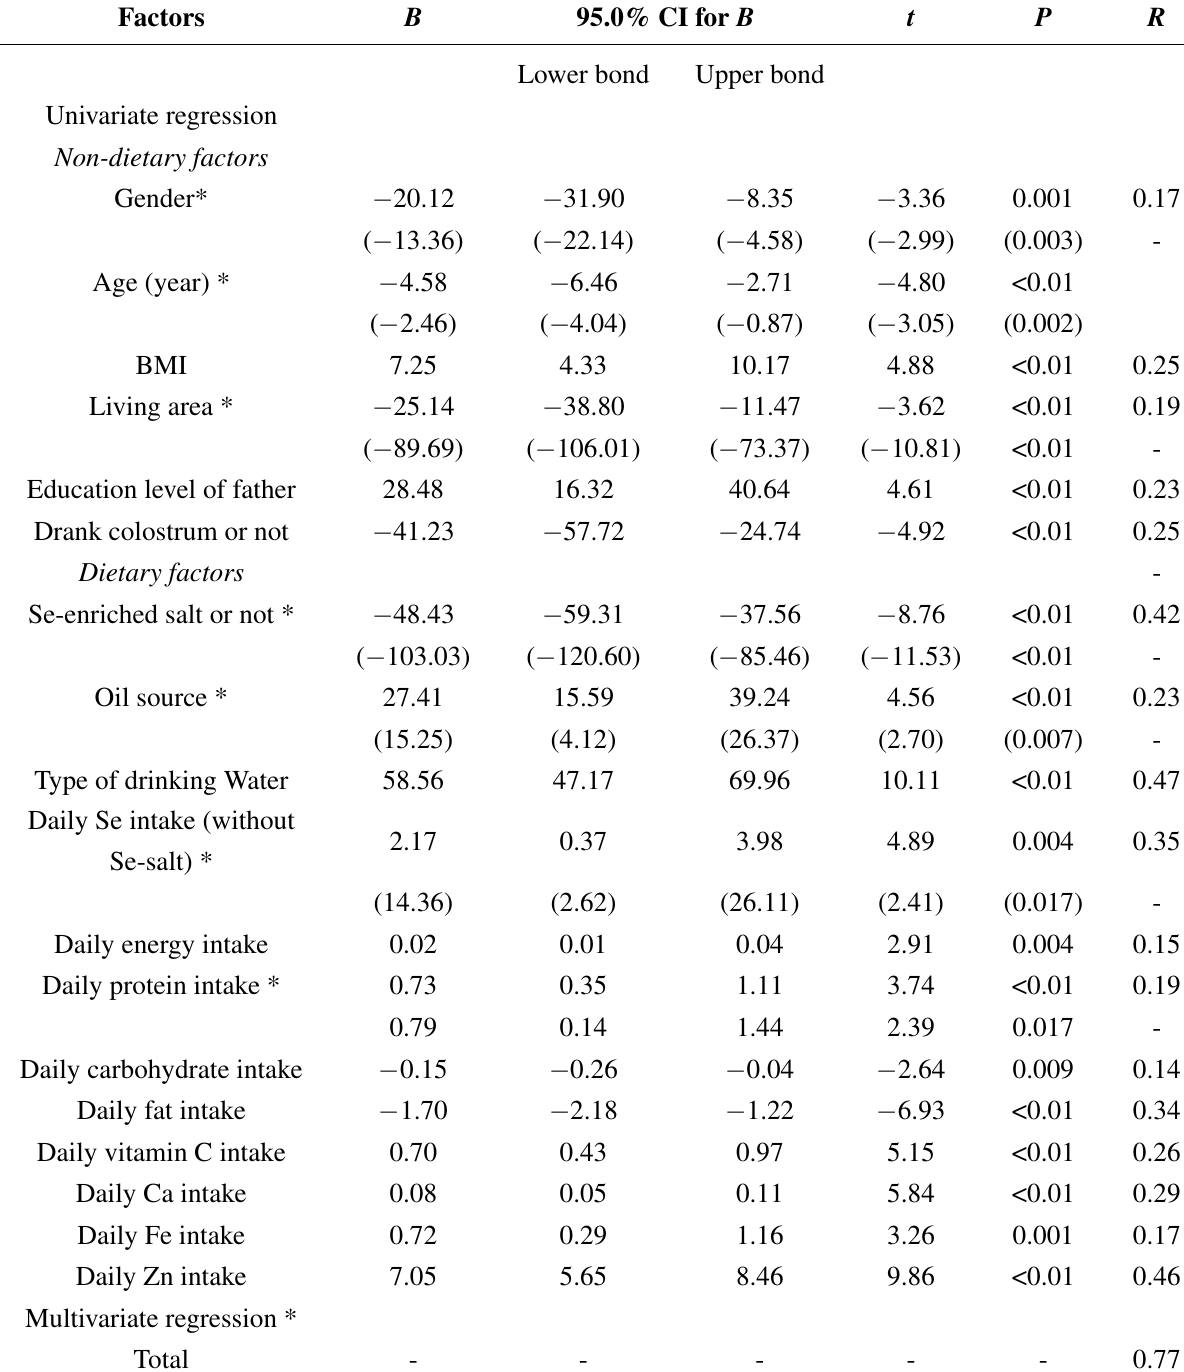
Table 3. Significant influence factors of hair Se content of children identified by univariate and multivariate regression